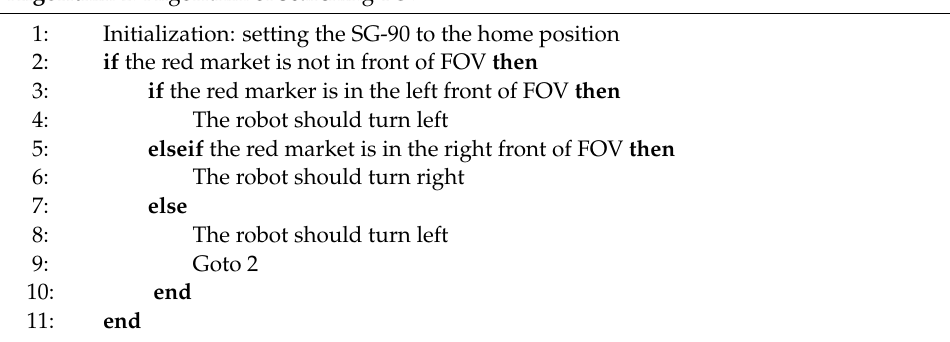
Algorithm 1 : Algorithm of searching TO .